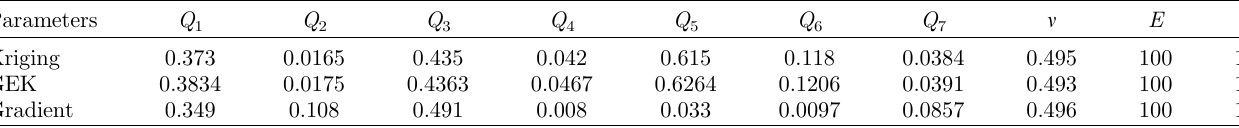
Table 4. Parameters of the optimized anechoic structure.